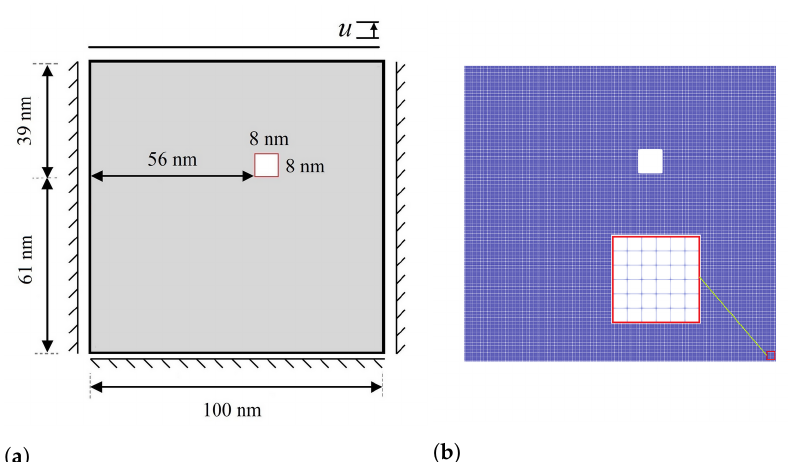
Figure 11. ( a ) Configuration of the specimen with a geometric inhomogeneity under Mode I; ( b ) finite element mesh of the model with an